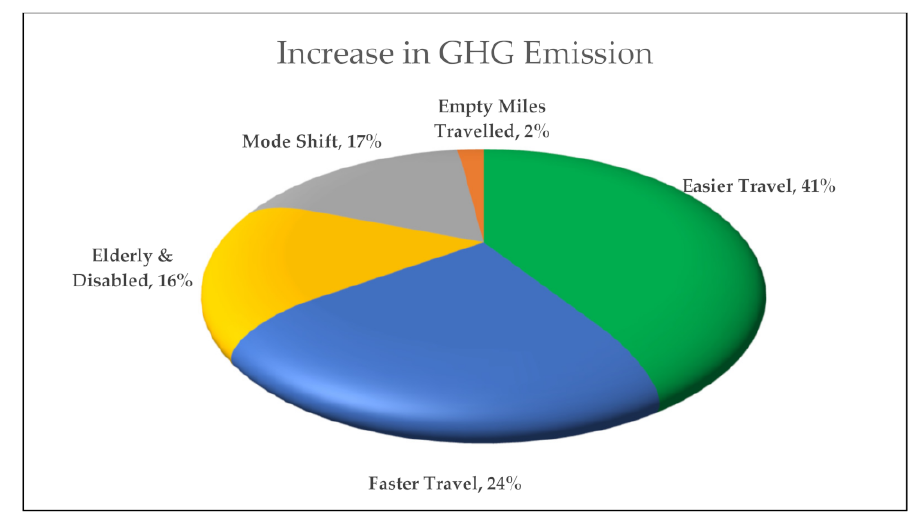
Figure 4. Average contribution of the causes on GHG emission increase.